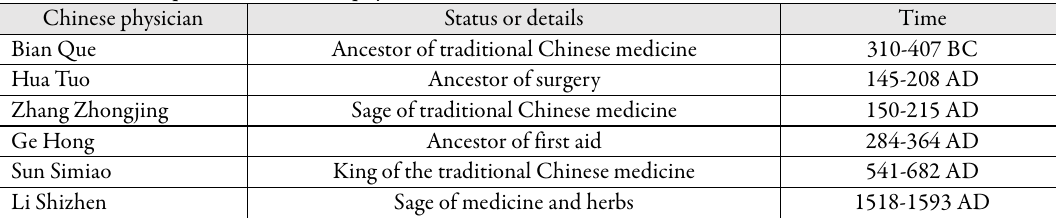
Table 1. Top 6 famous Chinese